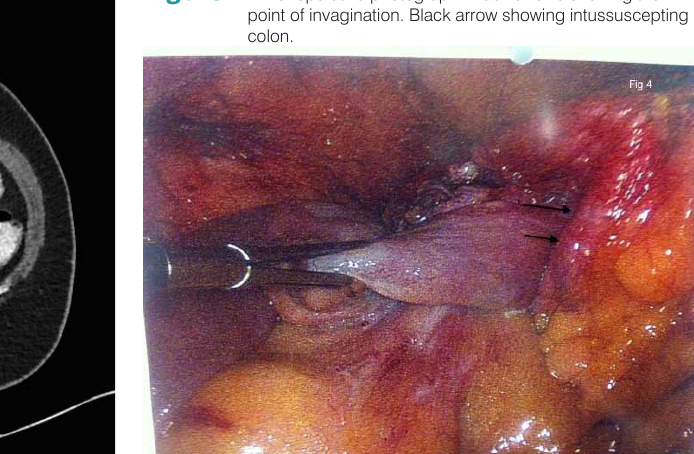
Figure 4. Per operative photograph. Black arrows showing the point of invagination. Black arrow showing intussuscepting